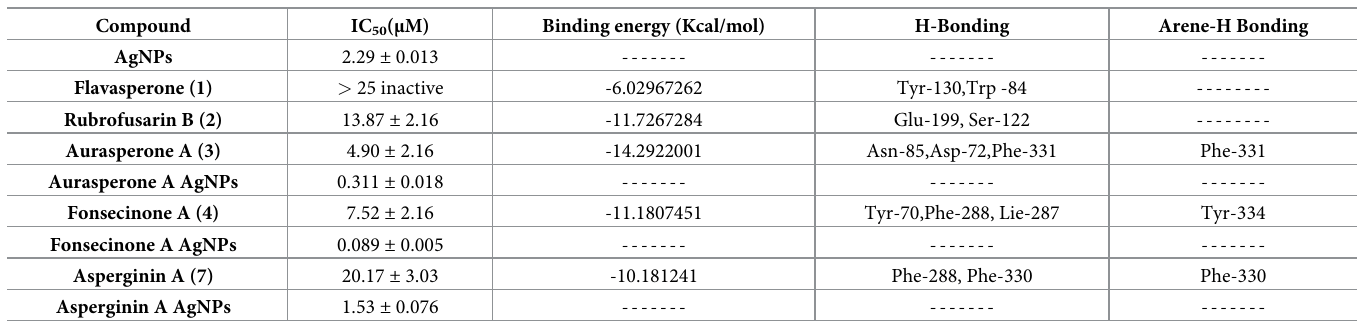
Table 1. AChEI activity of the isolated compounds and their synthesized AgNPs 1